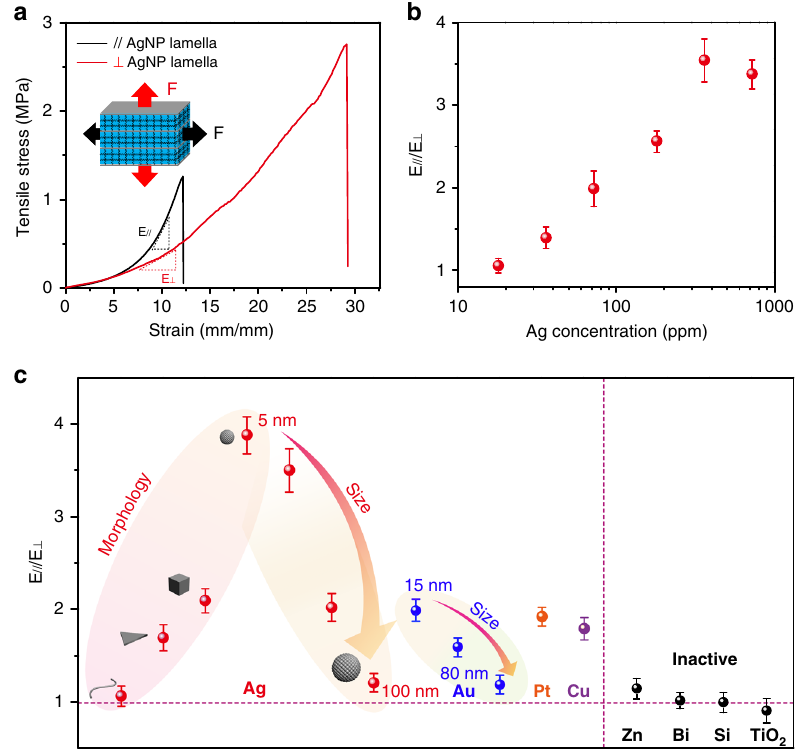
Fig. 3 Anisotropically mechanical behavior. a Tensile stress – strain curves of SNPP hydrogel with stress applied parallel and perpendicular to the AgNP lamella. b Tangent modulus ratio (E ∥ /E ⊥ ) calculated from tensile stress-strain curves of SNPP hydrogels, plotted against the content of silver NPs. c E ∥ /E ⊥ of hydrogels fabricated by nanostructures with varying sizes, morphologies, and compositions. Error bars show the SD with sample size of